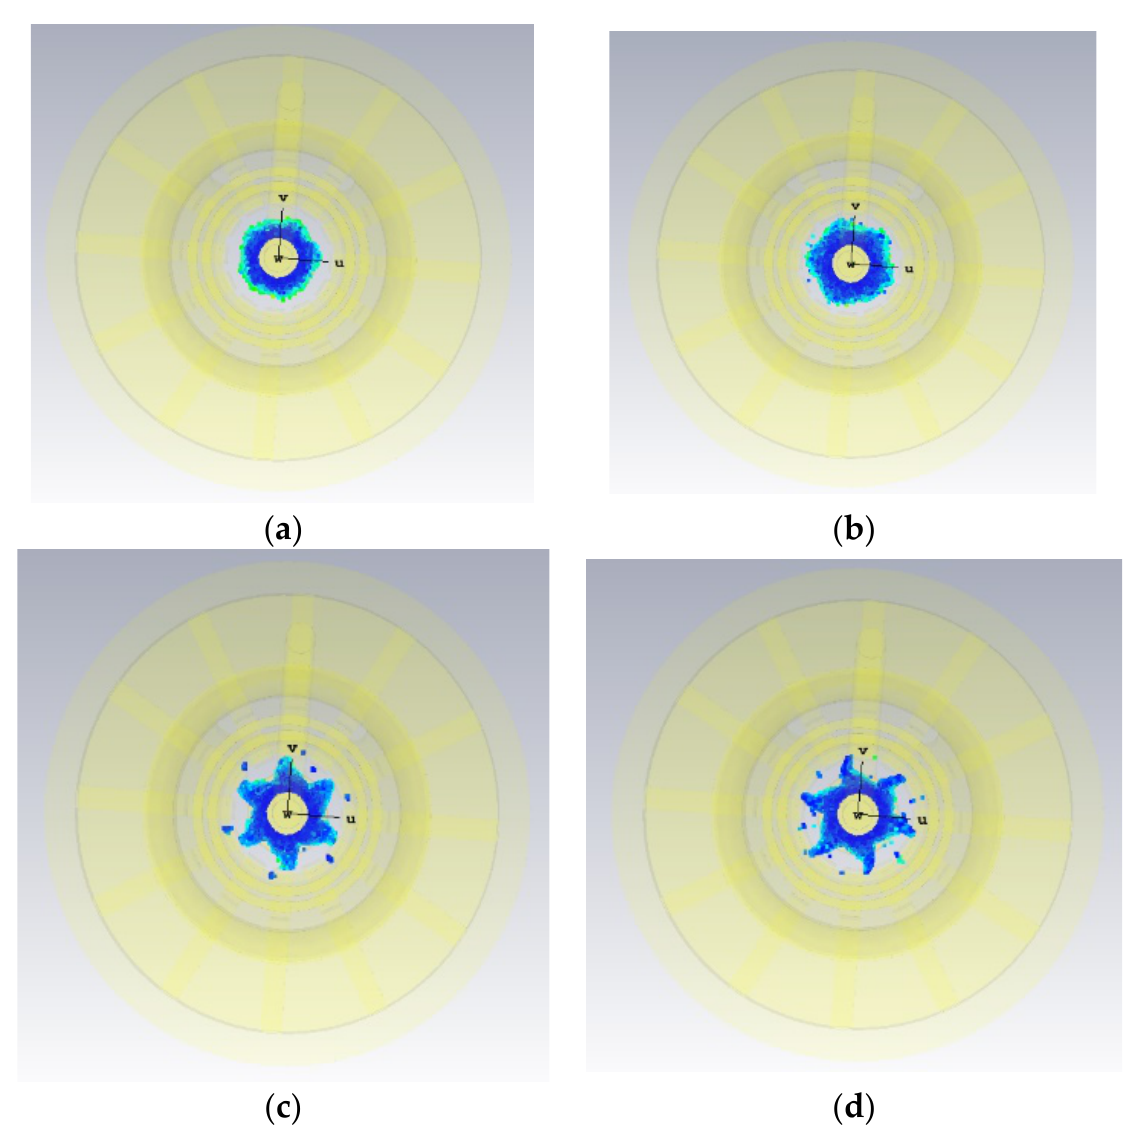
Figure 4. Electron flow distributions inside magnetron at 1000 ns of simulation time at magnetic field 3980 Gs and applied voltage 8000 V. ( a ) 100 ns. ( b ) 300 ns. ( c ) 425 ns. ( d ) 450